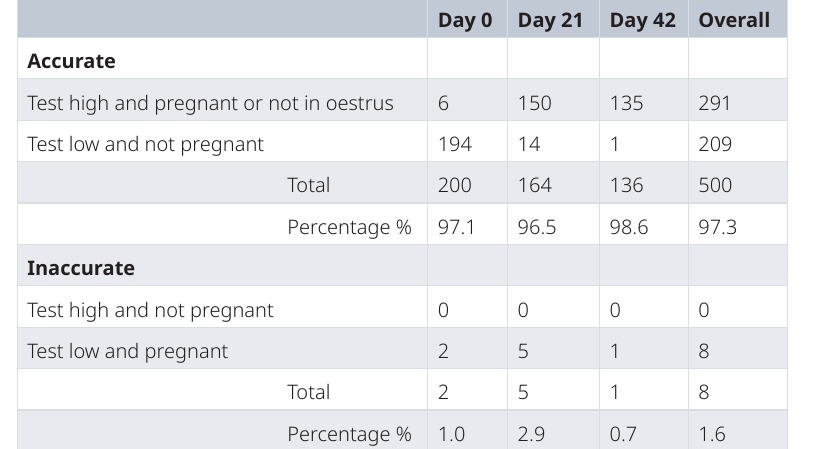
Table 2. P4 Rapid test accuracy – best-case